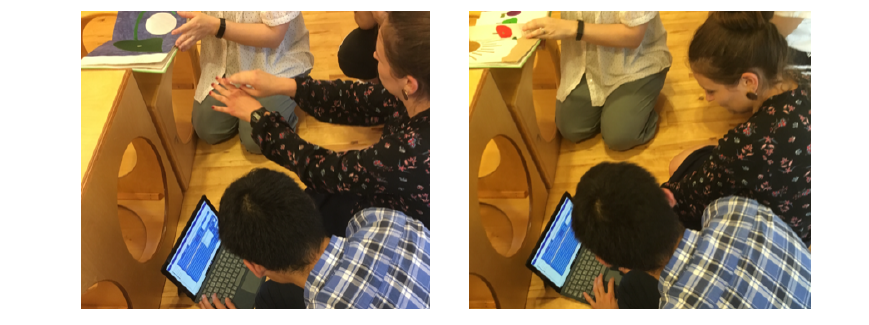
Figure 5. Example of real end users designing and programming a “ in the wild ” Human–Robot Interaction (HRI) scenario using current prototype of the RIZE robot End-User Development (EUD) interface for social robots.